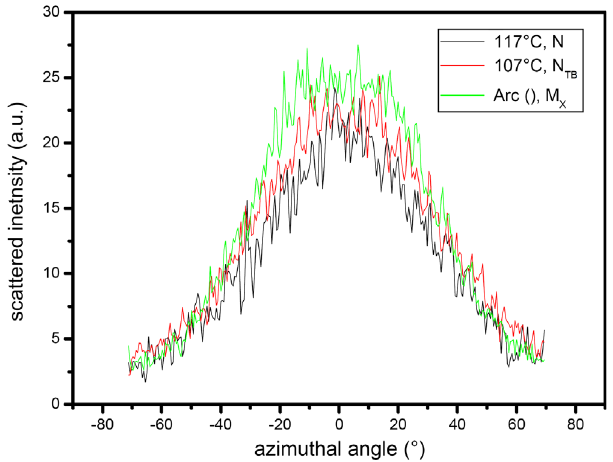
FIG. 17. Azimuthal profiles of the scattered x-ray intensity of a BP12 sample aligned in a magnetic field in the N , N mesophases.